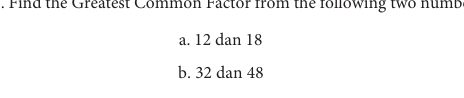
Figure 6: Question